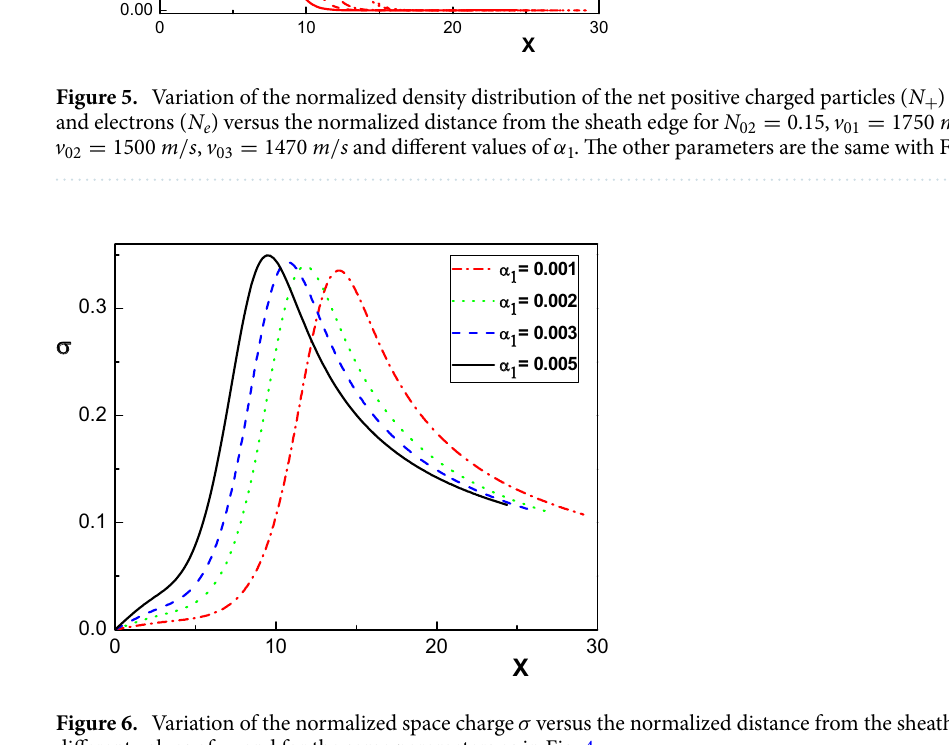
Figure 6. Variation of the normalized space charge σ versus the normalized distance from the sheath edge, for different values of α 1 and for the same parameters as in Fig. 4.